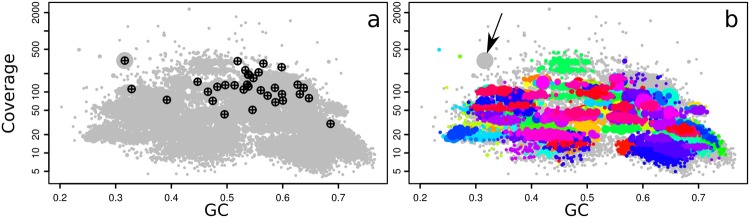
Coverage-GC plots for the synthetic AB metagenome (plot symbols are scaled by contig length). (a) Coverage levels show decrease at extreme GC values; note logarithmic scale in vertical axis. Crosshairs mark contigs with SSU rRNA genes, which tend to have higher coverage and more moderate GC values on average than other contigs. (b) Genome bins produced by MetaBAT as colored overlays (colors arbitrary), showing that not all contigs were assigned to a bin, including some high-coverage contigs; unbinned contigs shown in gray. The genome of Nanoarchaeum equitans assembled into a single contig (arrow) and was therefore not assigned to a bin by MetaBAT.